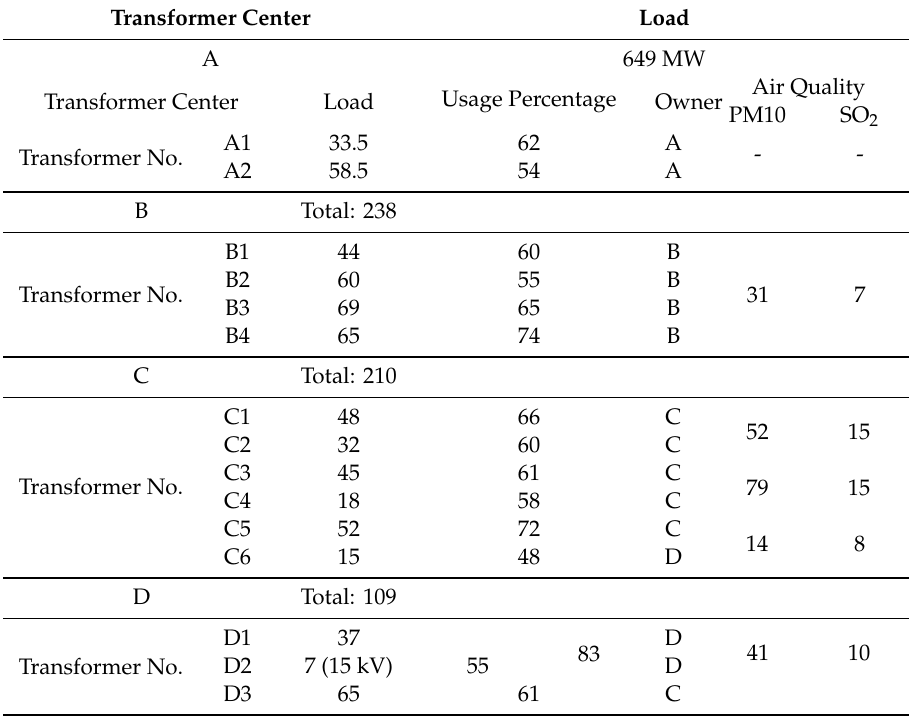
Table 2. A grid transformers’ center and their environmental condition. Transformer Center Load A 649 MW Transformer Center Load Usage Percentage Transformer